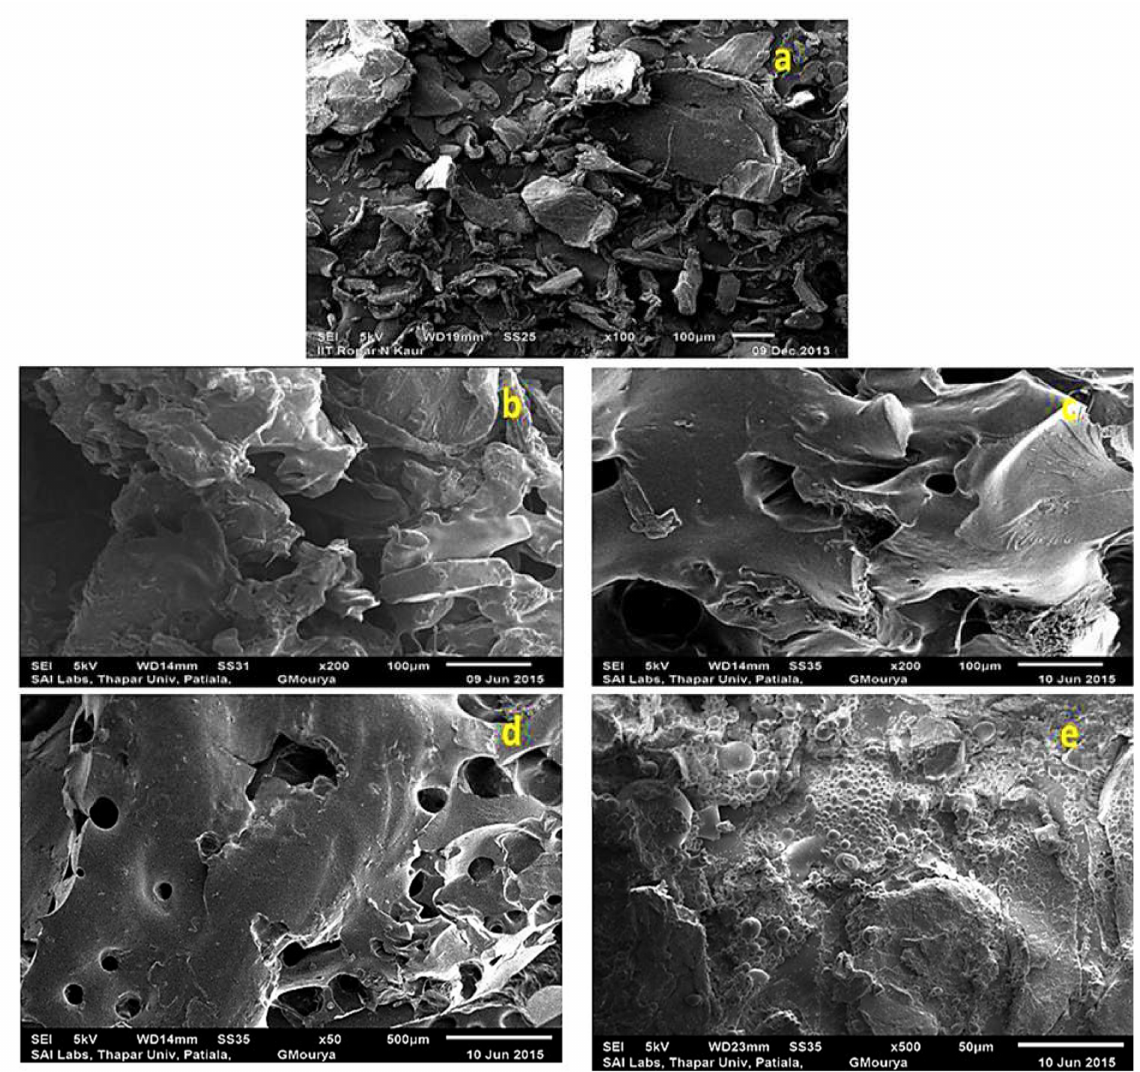
Figure 3. Comparative SEM analysis of chitosan backbone, graft copolymerized samples and crosslinked samples ( a ) chitosan, ( b ) Chit- g -polymer (NIPAAM) ( c ) Chit- g -polymer (NIPAAM- co -AA) ( d ) Chit- g -polymer (NIPAAM- co -AAm) ( e ) Chit- g -polymer (NIPAAM- co